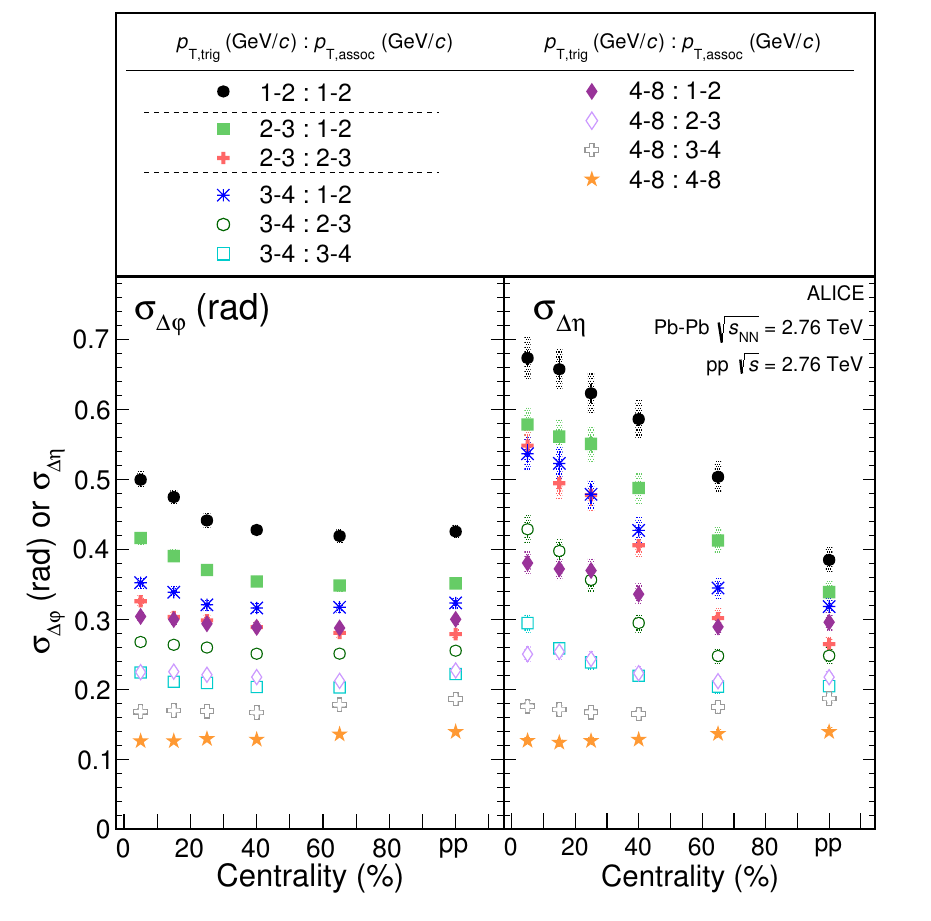
Figure 6. Shape parameters σ δφ (left panel) and σ δη (right panel) as a function of centrality in di ff erent p T ranges